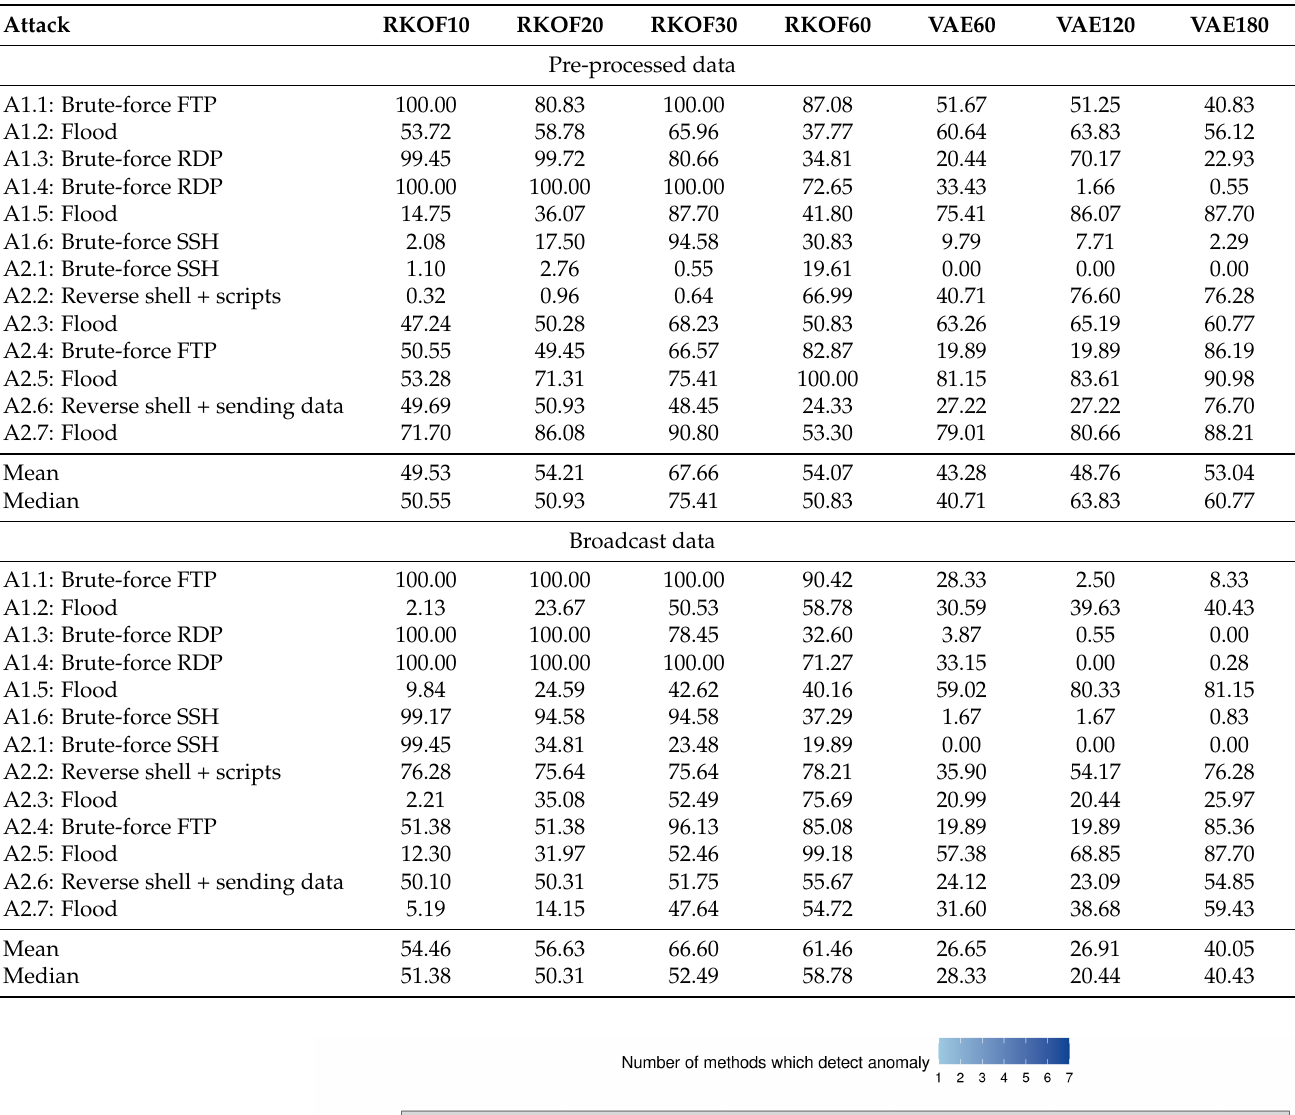
Table 3. Percentage of flows within attacks labelled as an anomaly.